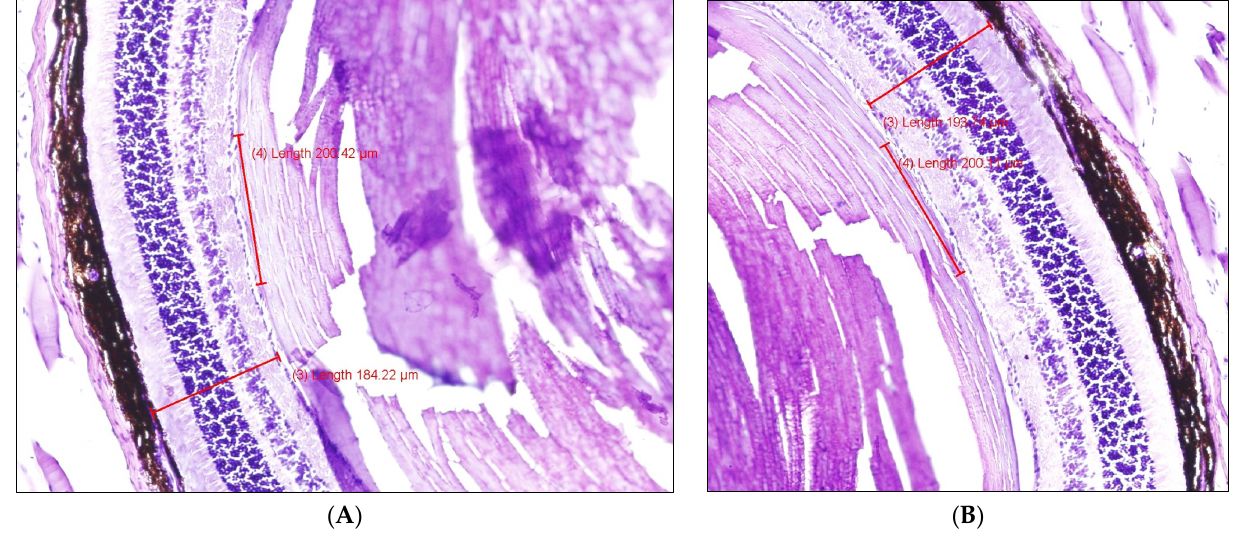
Figure 3. H&E staining showing the retinal thickness in WT mice. ( A ) microbead-injected eyes showing a retinal thickness of 184.22 µ m. ( B ) control eyes showing a retinal thickness of 193.74 µ m. H&E, hematoxylin and eosin; WT, wild type. Table 1. ( A ) Comparison of retinal thickness and RGC count in WT mice within treatment groups: right eyes with microbead-induced glaucoma under conditions of no treatment or AZ or sildenafil treatment compared with left control eyes. ( B ) Comparison of retinal thickness and RGC counts in WT mice between treatment groups: right eyes with microbead-induced glaucoma, untreated versus treated with either AZ or sildenafil.